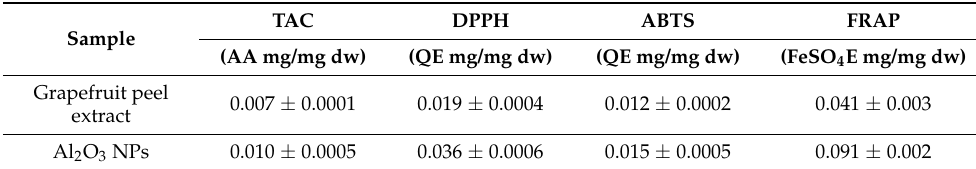
Table 1. The antioxidant activity of grapefruit peel extract and Al 2 O 3 NPs by TAC, DPPH, ABTS, and FRAPS assays.